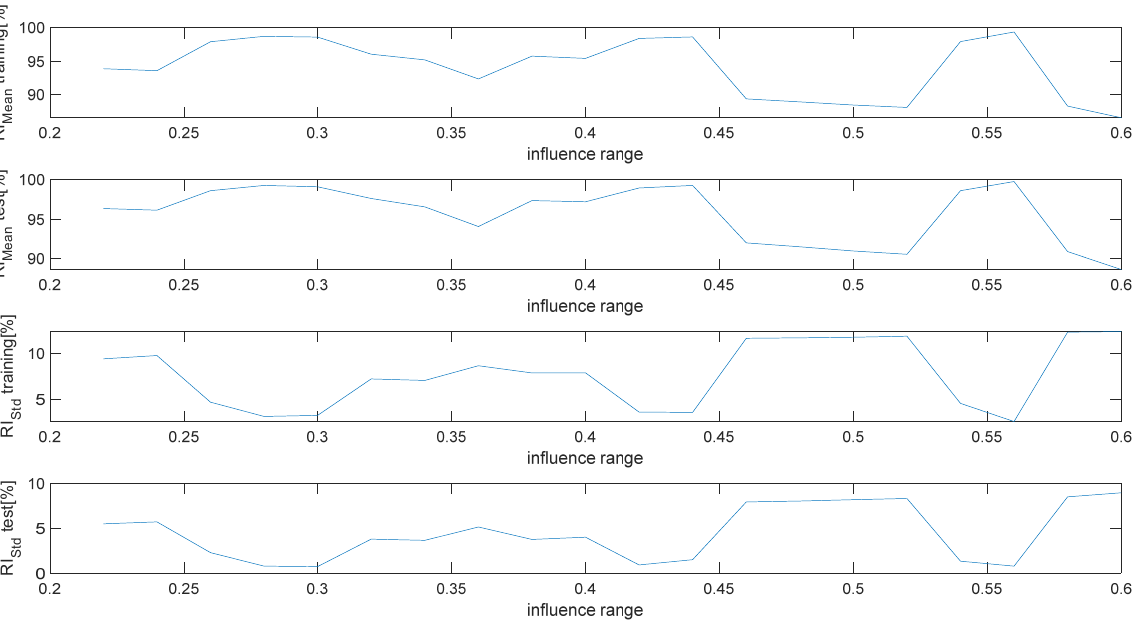
Figure 6. Features (8)–(10) estimated by the DWT for each of the computed levels d1-d5 . The whole set of patterns were randomized and divided in two sub-sets used for the training and test phases (ratio 60%/40%), allowing, respectively, for estimation of the NF inference and assessment of its performance. A study was performed to estimate the best “range of influence of the cluster center” minimizing performance indexes (13) and (14). The results shown in Figure 7, representing the behavior of such quantities as a function of the range of influence, allow for fixing the latter to the optimal value of 0.3.